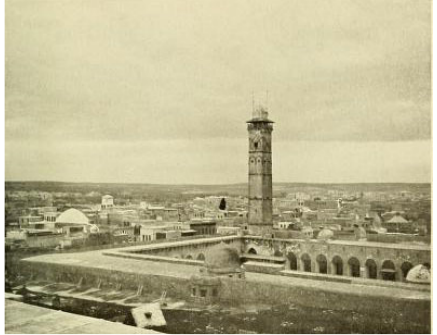
Figure 16. The Great Mosque of Aleppo with its minaret photographed by G. Bell. The minaret was destroyed in 2013. Photo: G. Bell 1909